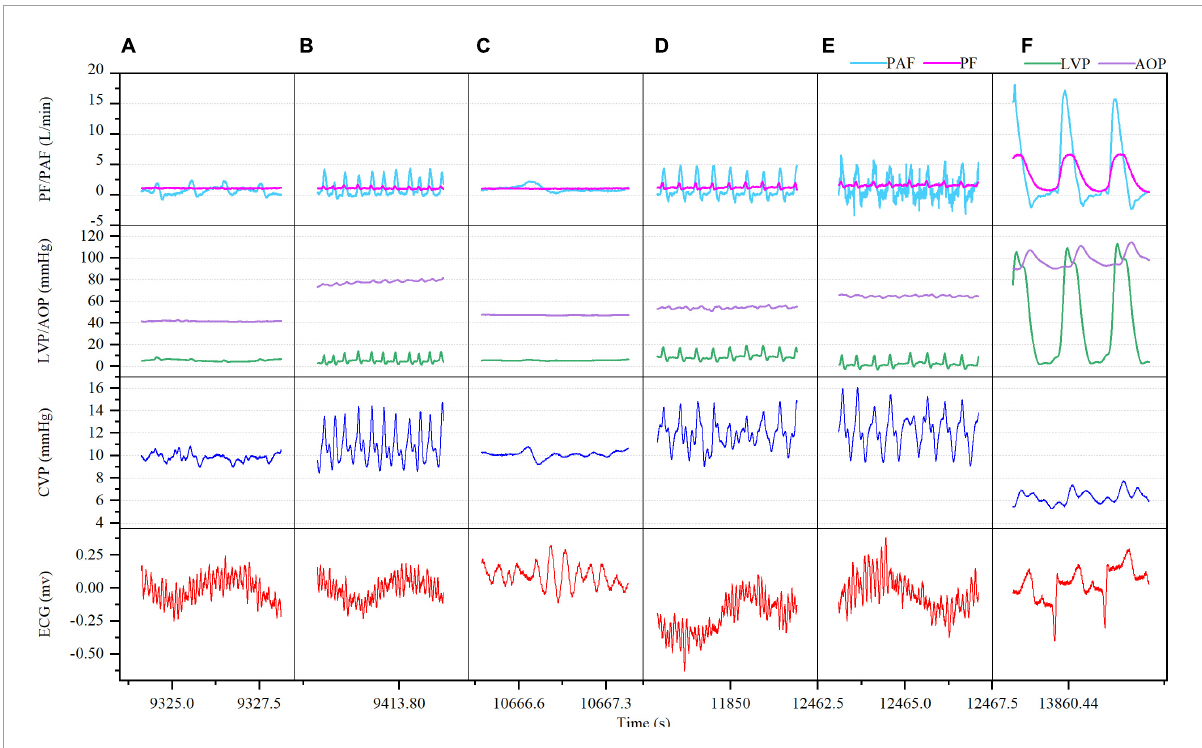
FIGURE2 Ventricular fibrillation (VF) with sinus rhythm after CF-LVAD implantation (Model A). (A) VF 5 min; (B) VF 10 min; (C) VF 30 min; (D) VF 50 min; (E) VF 60 min; (F) after defibrillation. PF, pump flow; PAF, pulmonary artery flow; LVP, left ventricular pressure; AOP, aortic